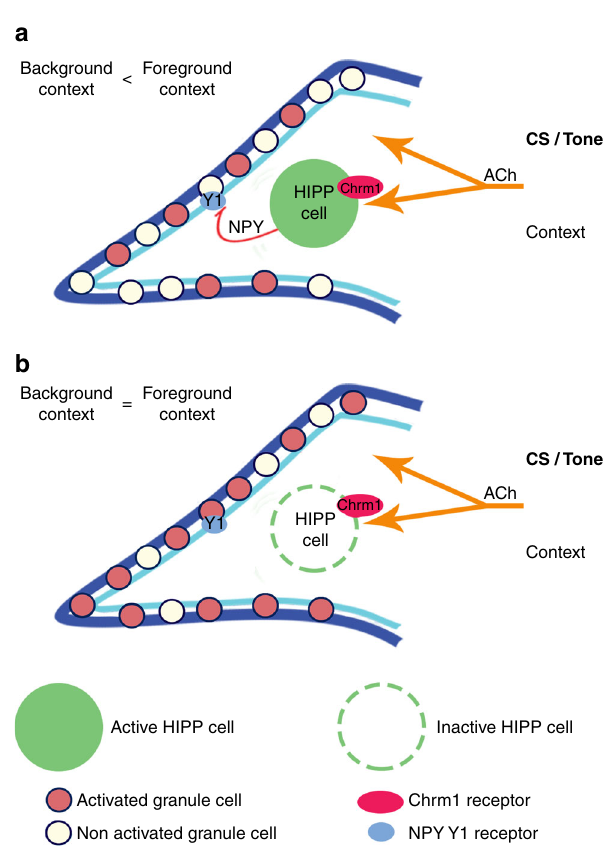
Fig. 7 A local circuit model for the cholinergic modulation of background context salience in the dentate gyrus. a HIPP cells act as relay stations in the septo-hippocampal pathway that adjust context memory strength during fear learning. Acetylcholine released from medial septal afferences during memory acquisition activates both granule cells and HIPP cells in the dentate gyrus. The cholinergic stimulation of HIPP cells via muscarinic M1 receptors (Chrm1) triggers their NPY release, which in turn via Y1